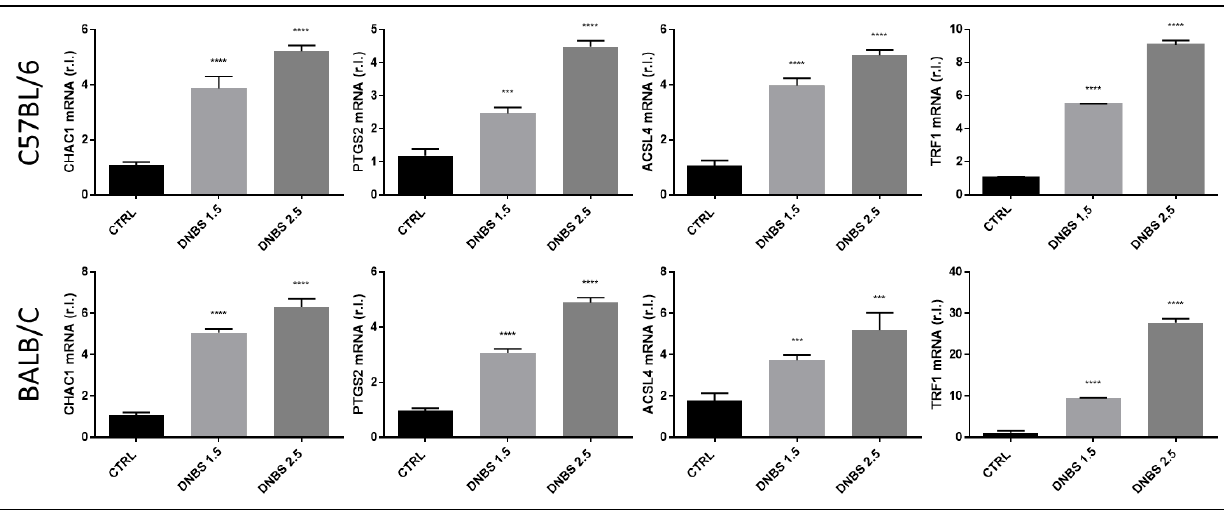
Figure 6. Ferroptosis induction. Colon from C57BL/6 (upper panels) or BALB/c (bottom panels) mice was cultivated for 5 h in a GEVS and untreated (CTRL) or treated with the indicated concentrations of DNBS and the expression levels of the well-known ferroptotic markers CHAC1, PTGS2, ACSL4 and TRF1 were evaluated by qPCR. Histograms represent mean ± SD of triplicate sample; **** p < 0.0001; *** p < 0.001.